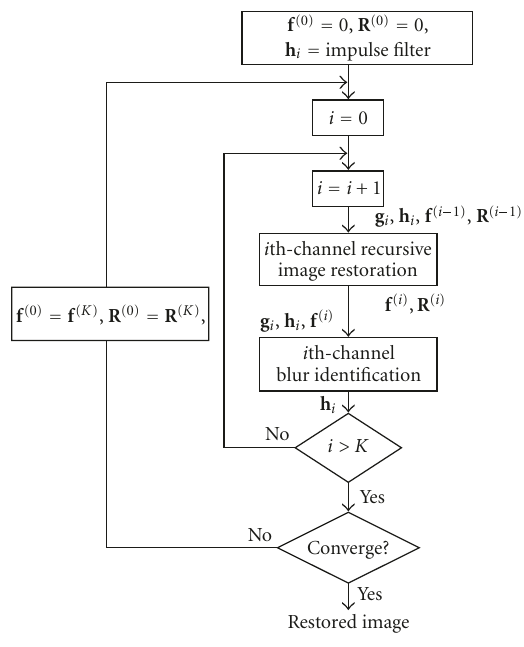
Figure 1: Schematic diagram of the proposed